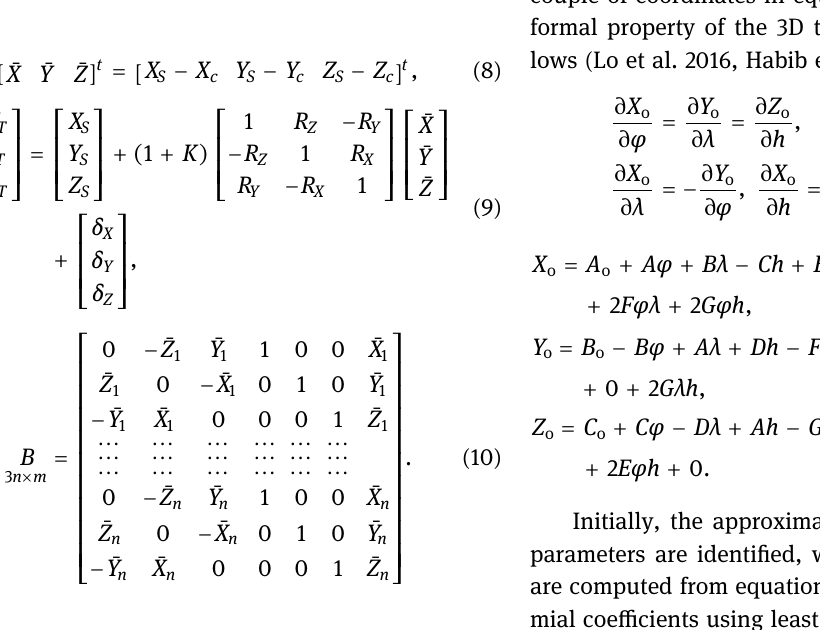
Figure 5: Graphical representation of Molodensky – Badekas